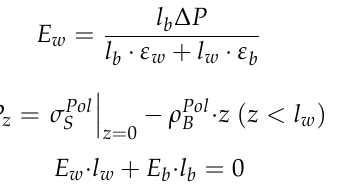
where P sp and P pz are the spontaneous and piezoelectric polarizations, respectively, and σ Pol S ( z ) = ∇ · P ( z ) , where ∇ is divergence operator, and P ( z ) is the be expressed by ρ Pol B polarization field along the z direction. The polarization-induced electric field ( E w ) in